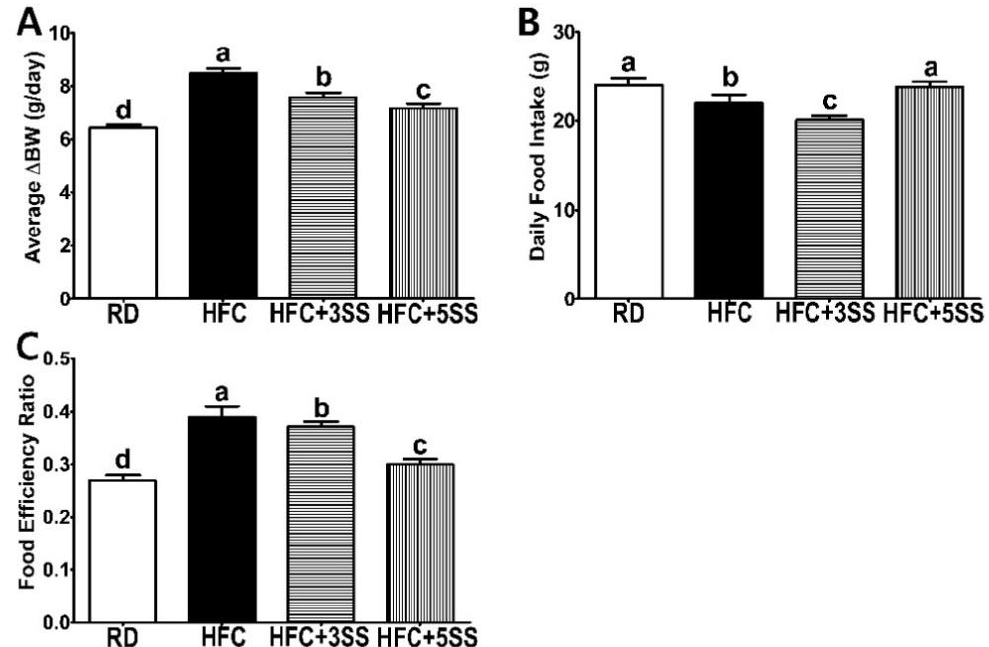
Figure 1. Effects of Stachys sieboldii Miq. root powder (SS) on body weight gain, food intake and food e ffi ciency ratio in HFC diet-fed rats. Experimental rats were fed a regular diet (RD) or a high-fat and high-cholesterol (HFC) diet with or without Stachys sieboldii Miq. root powder (SS; 3 or 5%) supplementation for 6 weeks. ( A ) Delta body weight gain (the final BW after dietary feeding—the initial BW), ( B ) daily food consumption and ( C ) food e ffi ciency ratio were measured. RD, regular diet; HFC, high-fat and high-cholesterol diet; HFC + 3SS, High-fat and high-cholesterol diet + 3% of Stachys sieboldii Miq. root powder; HFC + 5SS, high-fat and high-cholesterol diet + 5% of Stachys sieboldii Miq. root powder. Values are means ± standard deviation, n = 8. Data were analyzed using one-way ANOVA followed by Tukey’s post hoc test. Means labeled without a common letter differ significantly, p < 0.05.